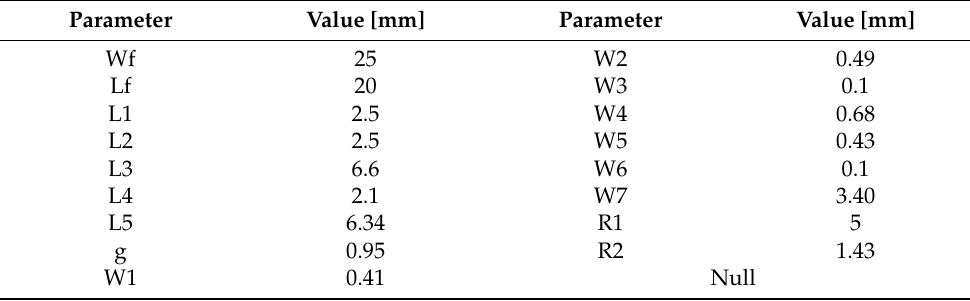
Figure 7. Single-wing UWB multimode resonator (MMR) bandpass filter and its equivalent circuit. Table 3. Design parameters of the single-wing UWB MMR bandpass filter.